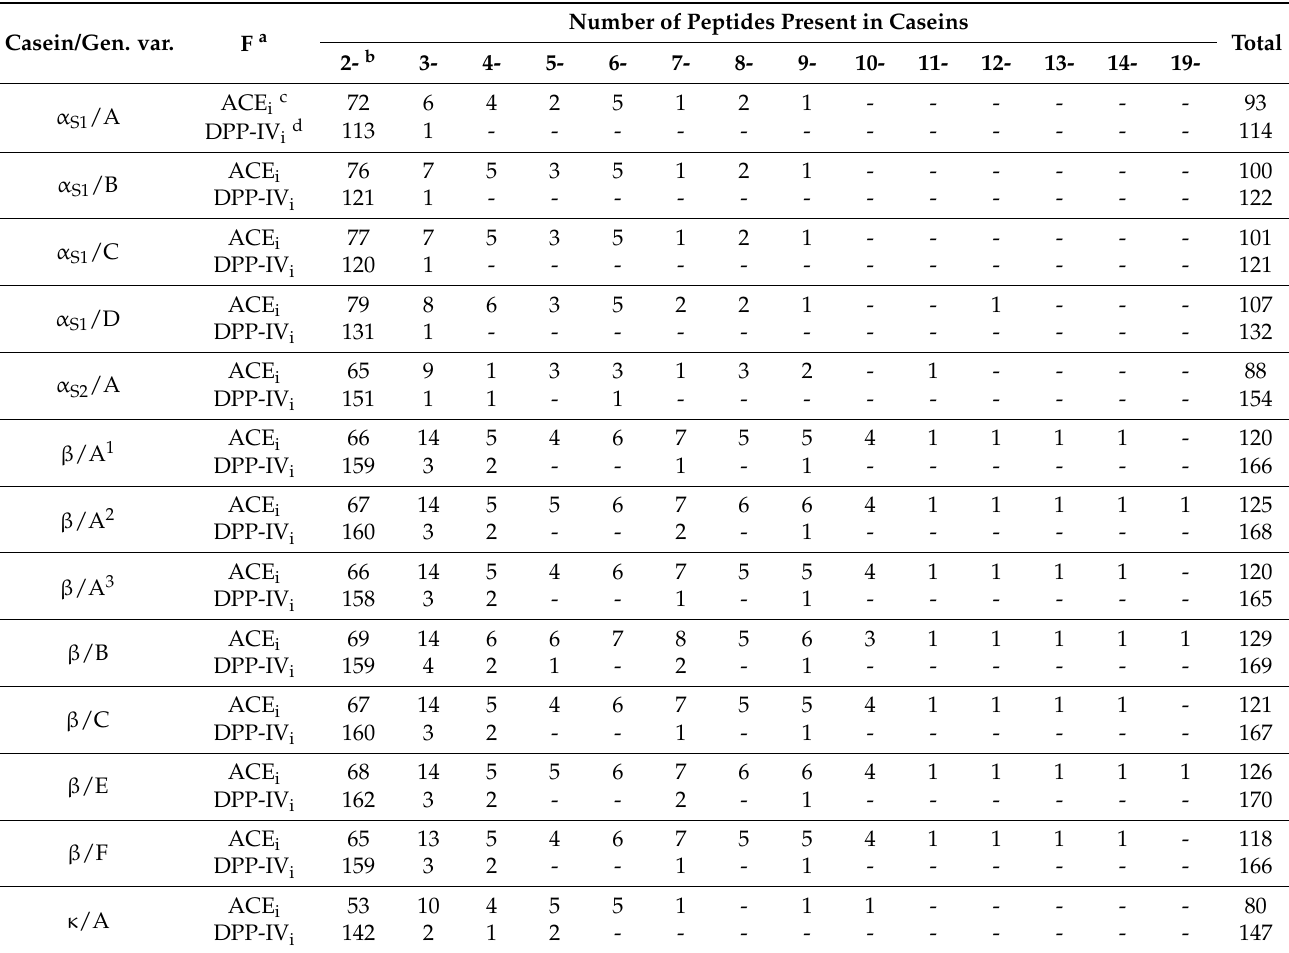
Table 1. Number of DPP-IV and ACE inhibitors potentially present in bovine casein sequences. Casein/Gen.